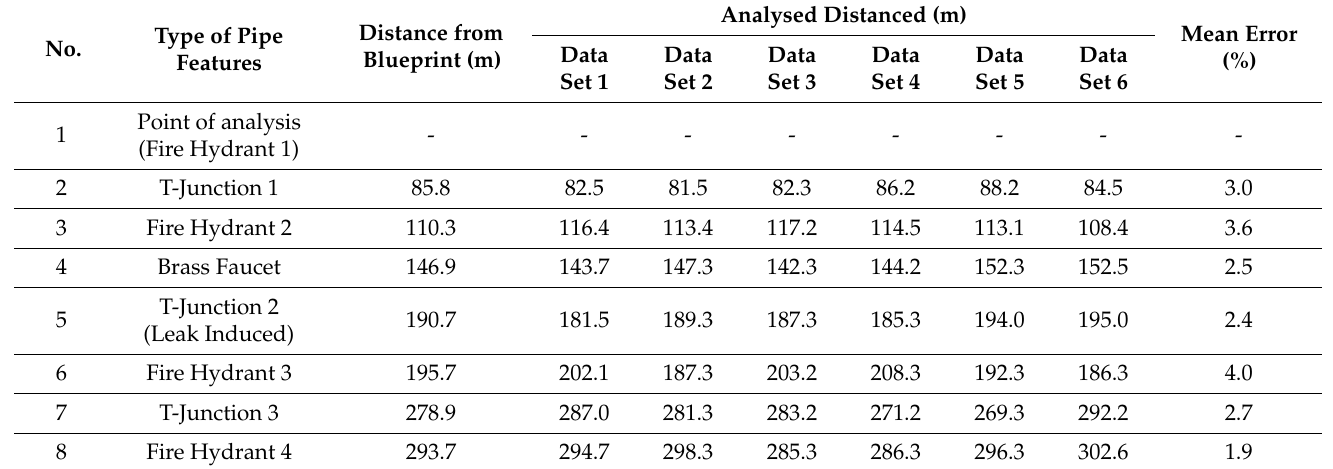
Table 5. NIKAZ evaluation for the system with 5 mm leak induced on fire hydrant 2.